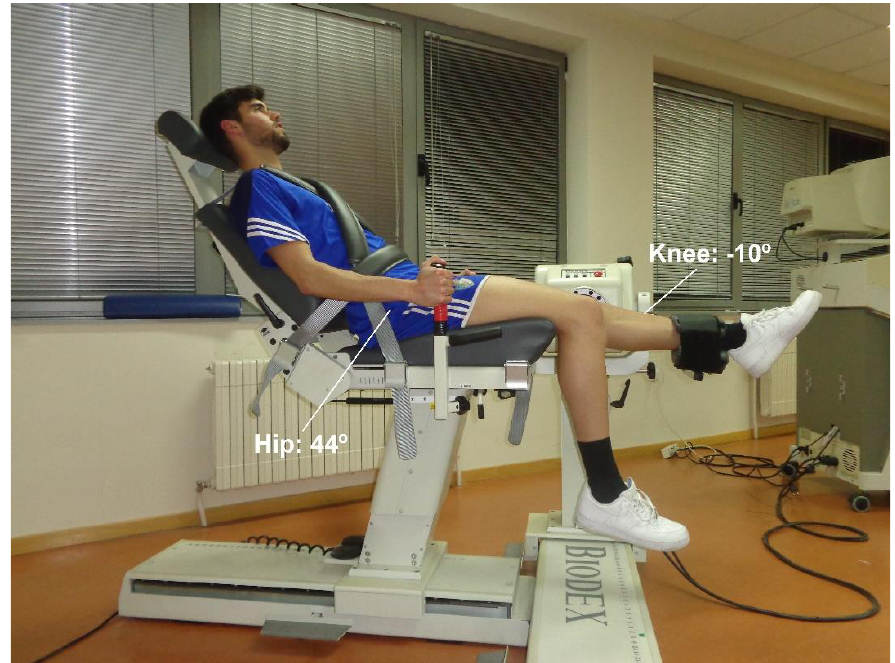
Figure 3. One of the sample subjects in the unified reclined position, at a 44° hip flexion and −1 0° knee extension.